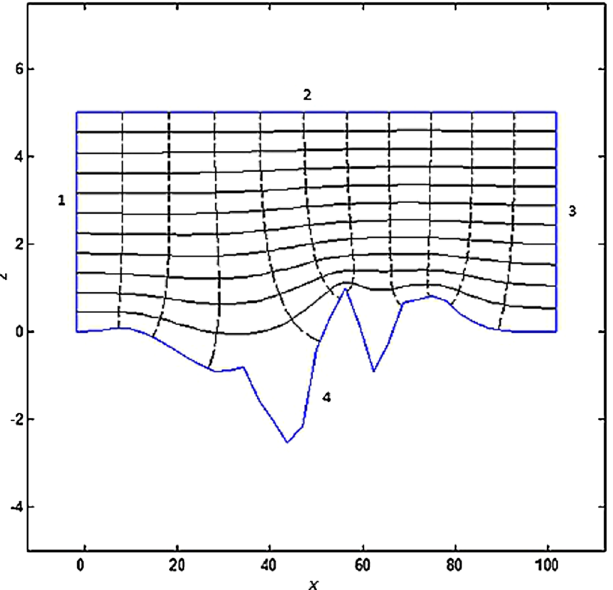
materials.FIG. 5. Configuration used for simulation model calculation on cross section fragment of the real BCP-treated sample surface.